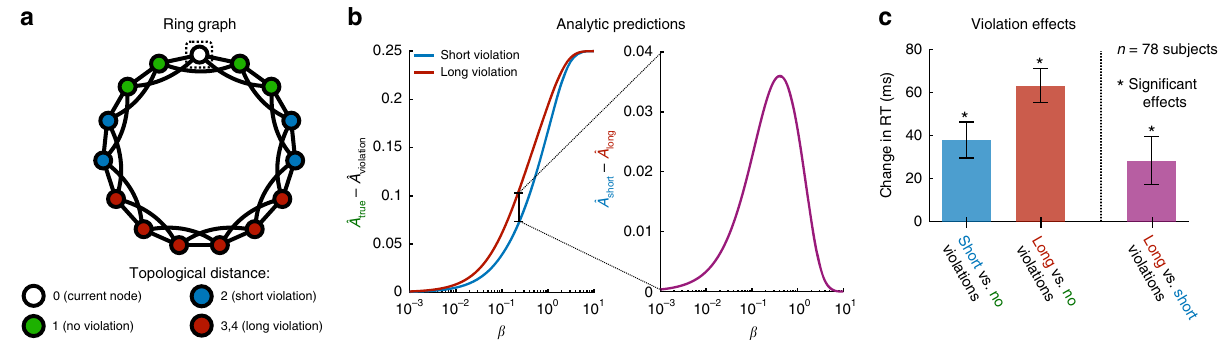
Fig. 6 Network violations yield surprise that grows with topological distance. a Ring graph consisting of 15 nodes, where each node is connected to its nearest neighbors and next-nearest neighbors on the ring. Starting from the boxed node, a sequence can undergo a standard transition (green), a short violation of the transition structure (blue), or a long violation (red). b Our model predicts that subjects ’ anticipations of both short (blue) and long (red) violations should be weaker than their anticipations of standard transitions (left). Furthermore, we predict that subjects ’ anticipations of violations should decrease with increasing topological distance (right). c Average effects of network violations across 78 subjects, estimated using a mixed effects model (Supplementary Tables 10 and 11), with error bars indicating one standard deviation from the mean. We fi nd that standard transitions yield quicker reactions than both short violations ( p < 0.001, t = 4.50, df = 7.15 × 10 4 ) and long violations ( p < 0.001, t = 8.07, df = 7.15 × 10 4 ). Moreover, topologically shorter violations induce faster reactions than long violations ( p = 0.011, t = 2.54, df = 3.44 × 10 3 ), thus con fi rming the predictions of our model. Measurements were on independent subjects, and statistical signi fi cance was computed using two-sided F -tests. Source data are provided as a Source Data fi indirectly estimating β in the serial response experiment.